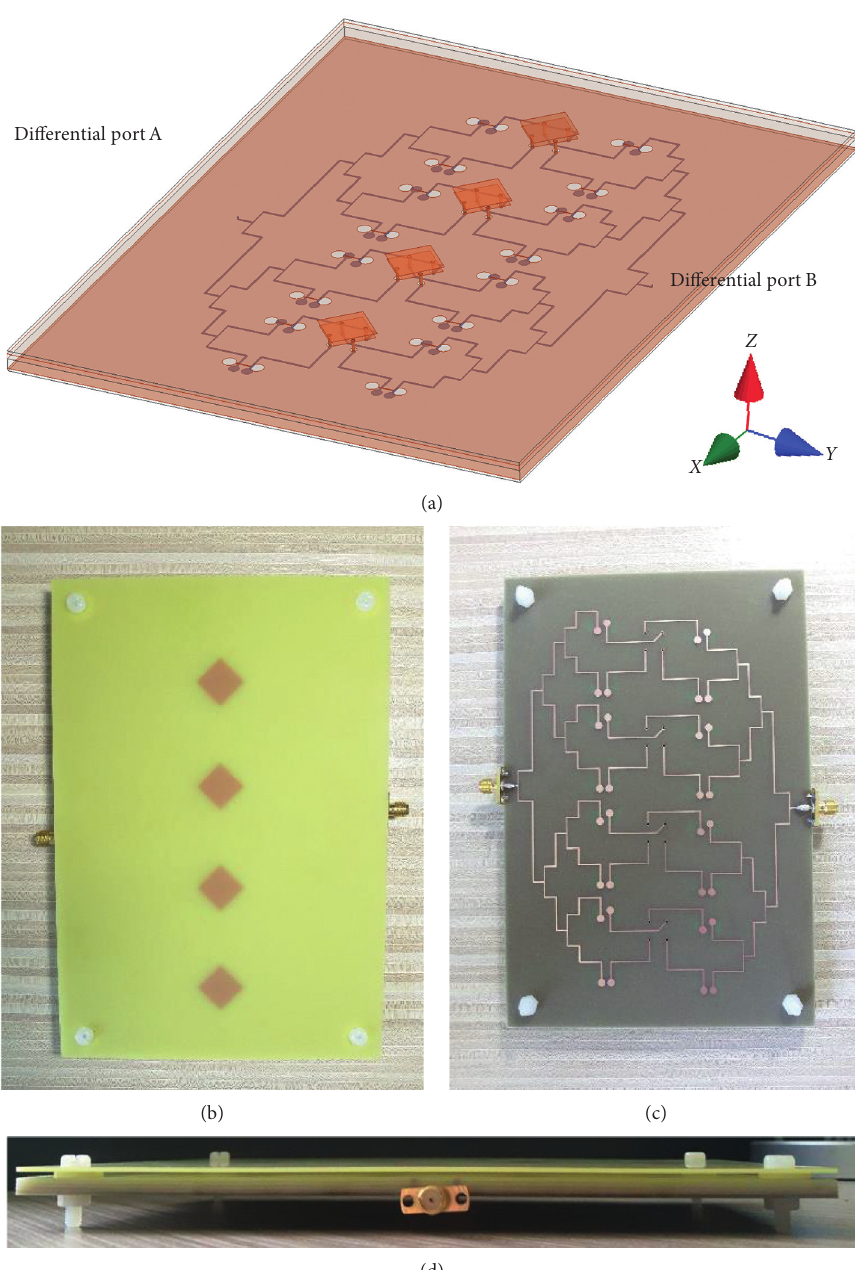
Figure 14: Simulation model and fabricated prototype of the 1 × 4 antenna array. (a) Simulation model, (b) top view, (c) back view, and (d) side view of the fabricated